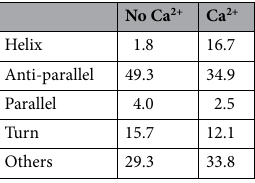
Table 2. Estimated secondary structure content